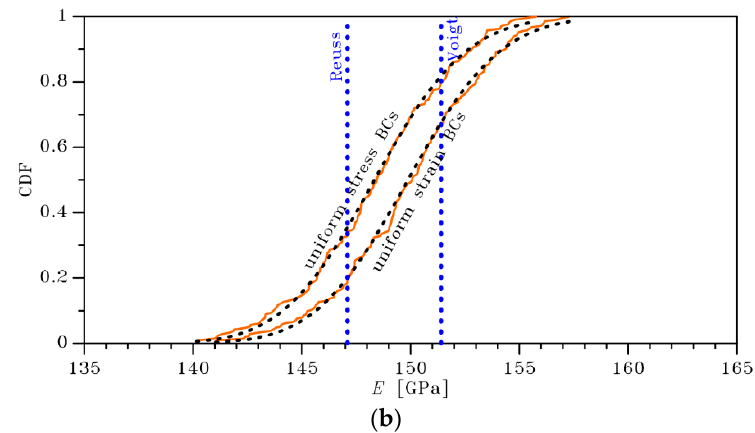
Figure 3. Stochastic homogenization, effect of the SVE size on the cumulative distribution functions of the bounds on the homogenized in-plane Young’s modulus E of a polysilicon film featuring s g = 0.5 µ m: ( a ) 2 × 2 µ m SVE, ( b ) 3 × 3 µ m SVE.